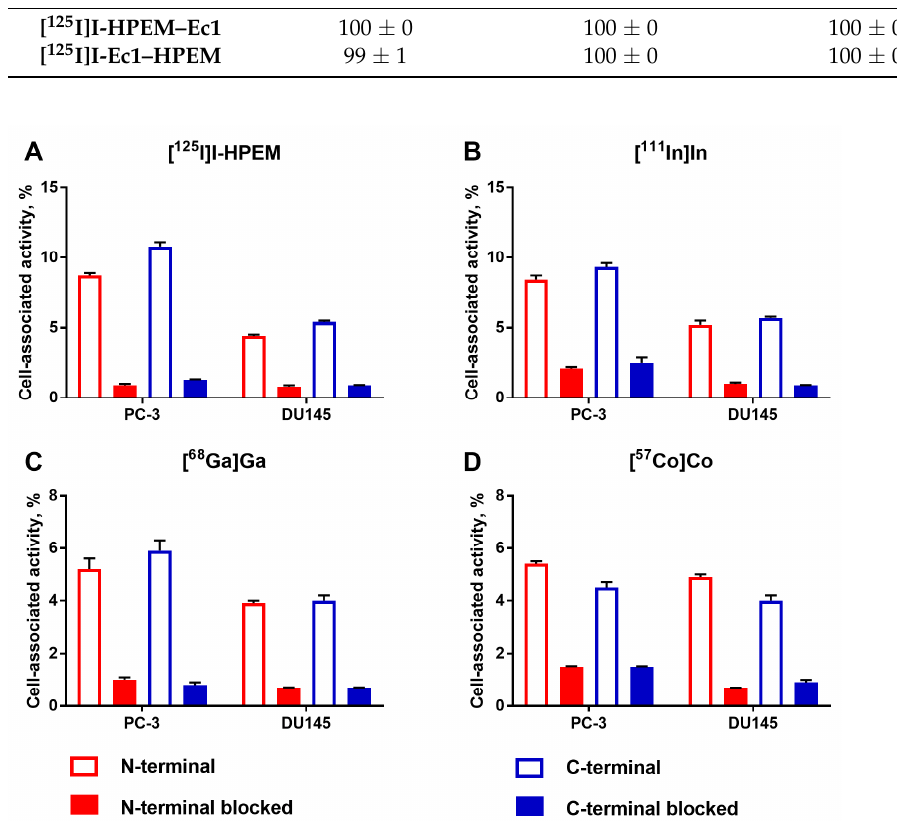
Figure 2. Binding specificity of Ec1 conjugates radiolabeled with ( A ) [ 125 I]I-HPEM, ( B ) [ 111 In]In, ( C ) [ 68 Ga]Ga and ( D ) [ 57 Co]Co at the N - or the C -terminus, to EpCAM-expressing PC-3 and DU145 prostate cancer cells in vitro. For blocking, a 100-fold molar excess of non-labeled Ec1 was added to the blocked groups. The final concentration of radiolabeled compounds was 2 nM. The data are presented as mean from three samples ± SD. Table 4. Dissociation equilibrium constants (K D ) for the interaction between Ec1 variants labeled with [ 57 Co]Co, [ 111 In]In and [ 125 I]I-HPEM at N- or C-terminus, and DU145 prostate cancer cells. K D , nM Compound/Label Position